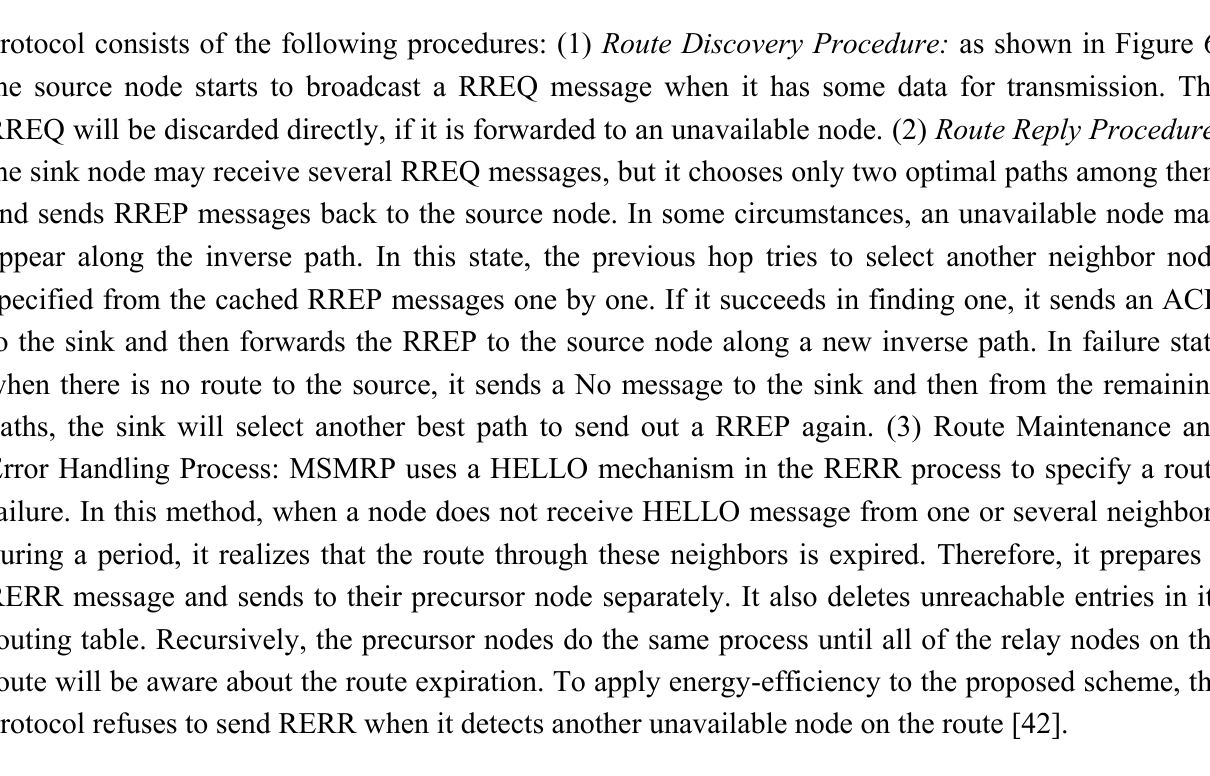
Figure 6. RREQ dissemination procedure in MSMRP